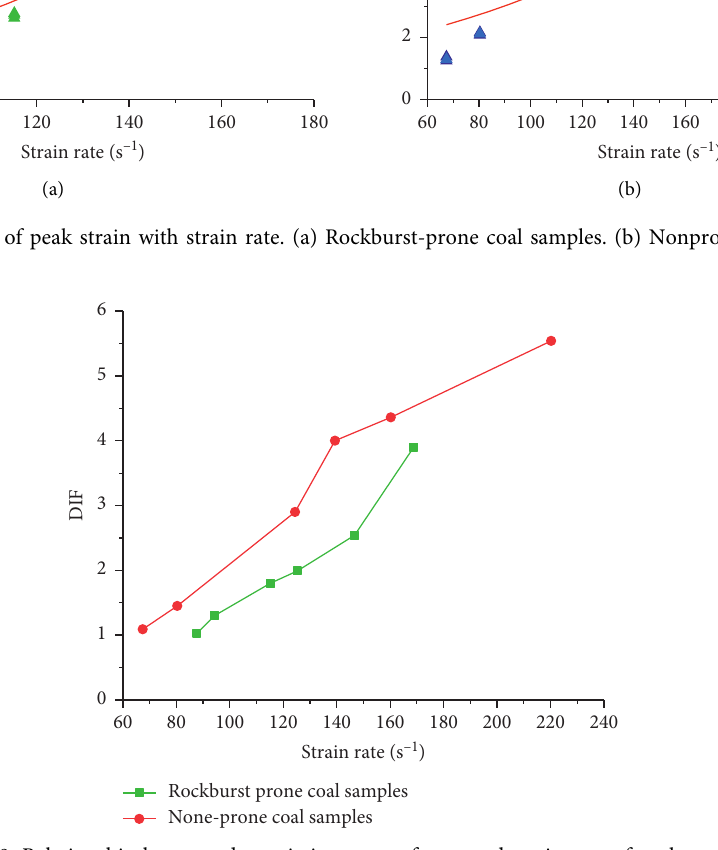
Figure 9: Relationship between dynamic increment factor and strain rate of coal